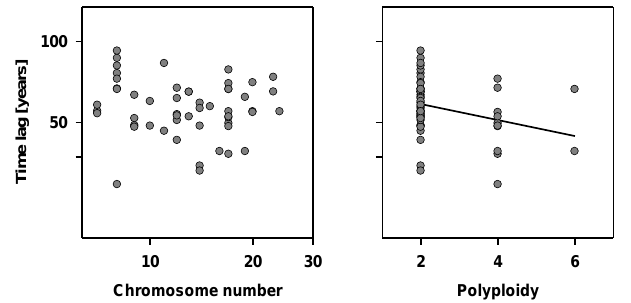
Figure 1. (left) Correlation between the time lag (in years) of alien plants in the state Brandenburg of Germany and their haploid number of chromosomes ( n = 53, r = − 0 . 13, P = 0 . 36). (right) Correlation between the time lag of alien plants and polyploidy ( n = 53, r = − 0 . 39, P = 0 . 03). See text for further explanations. Note that in the left panel both axes were log 10 -transformed.